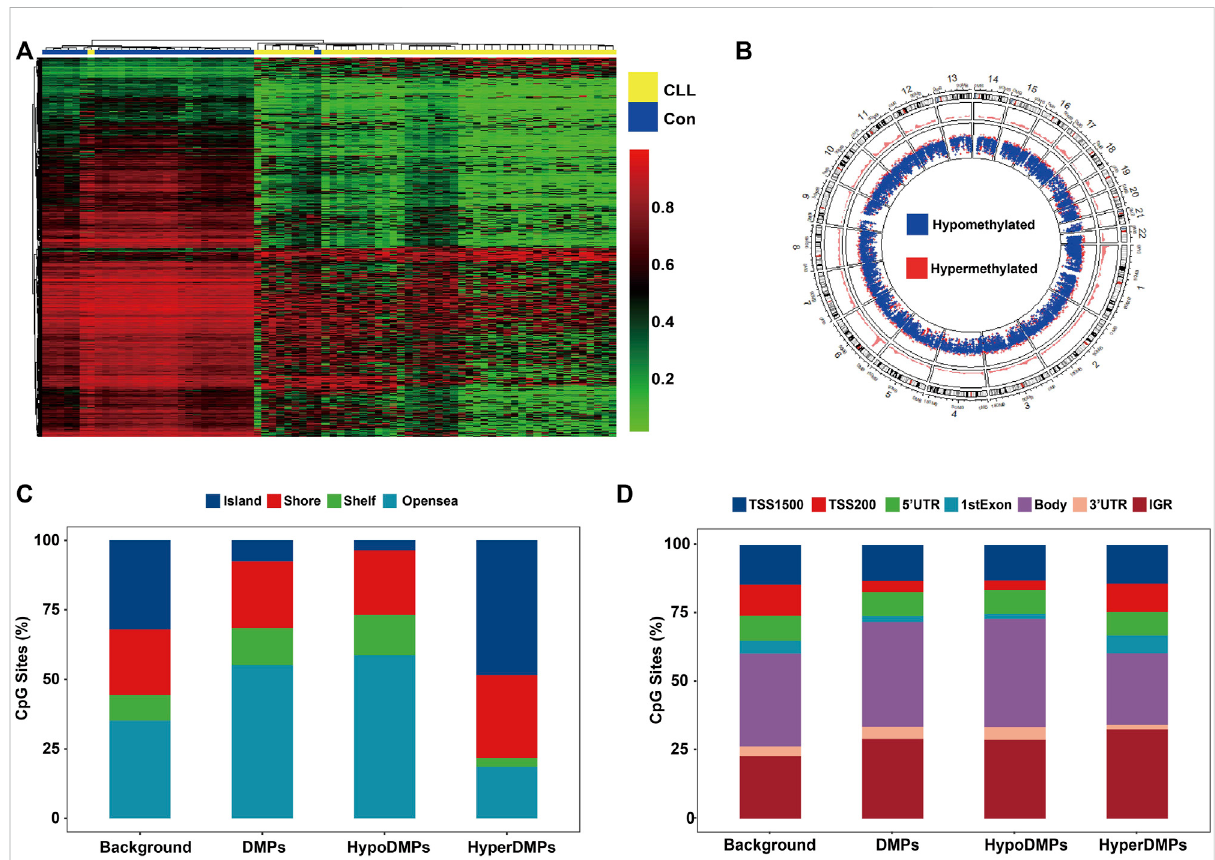
FIGURE 3 CLL-related DMPs identi fi ed in our study (A) Hierarchical analysis was performed on the beta value of all CLL-related DMPs (N = 34,797). DMPs withFDRlowerthan0.05wereselectedadjustedbyageandsexusinglinearregression.HeatmapofCLL-relatedDMPsshowedmoreperturbedand decreased methylation in CLL patients. (B) Density plot of DMP distribution on 22 human autosomes (C) Barplots depicting the percentage of DMPs was on each CGI feature (Island, Shore, Shelf, and Opensea). CpG Islands contained more hypermethylated DMPs. Opensea and Shelf regions contained more hypomethylated DMPs. (D) Barplots depicting the percentage of DMPs was on each genomic feature (TSS1500, TSS200, 5 ′ UTR, 1stExon,Body,3 ′ UTR, and IGR). DMPs inthepromoter region includingtheTSS200, TSS1500,1stExon region showed more hypermethylated.DMPs in the body and 3 ′ UTR region showed more hypomethylated. Background: Total 406,879 CpGs after quality control; DMPs: Total 34,797 CLL- related DMPs; HyperDMPs: Hypermethylated DMPs in CLL patients; HypoDMPs: Hypomethylated DMPs in CLL